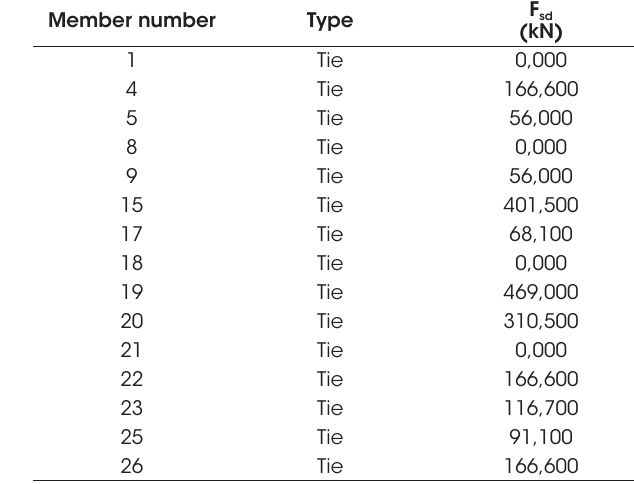
Design axial traction